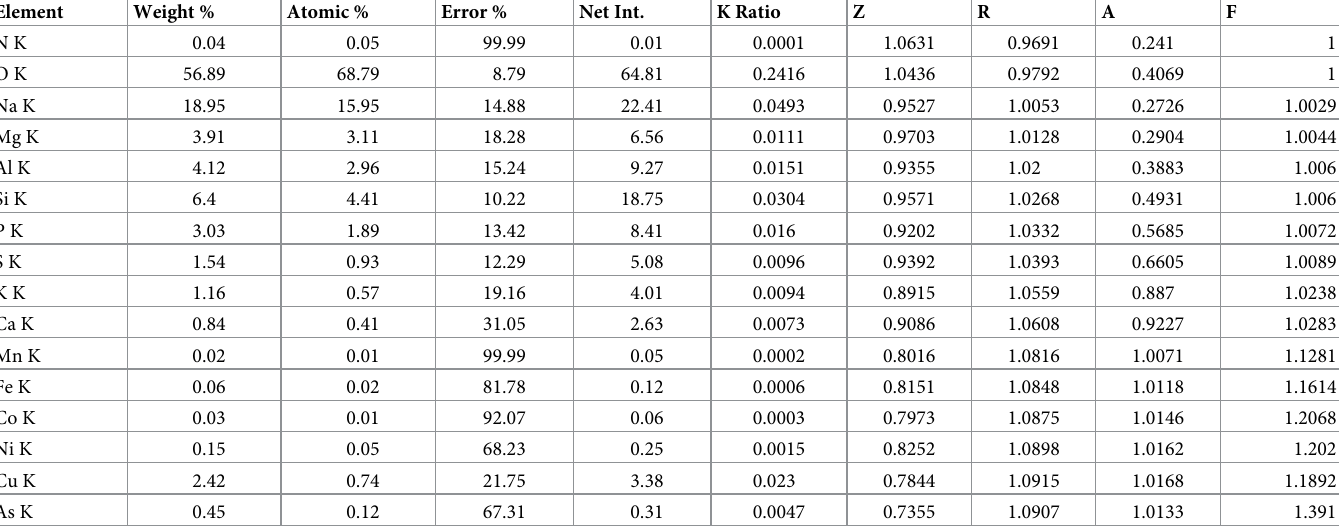
Table 1. List of the elements value generated by FESEM-EDS analysis in Yak dung sample collected from summer season. Element Weight %